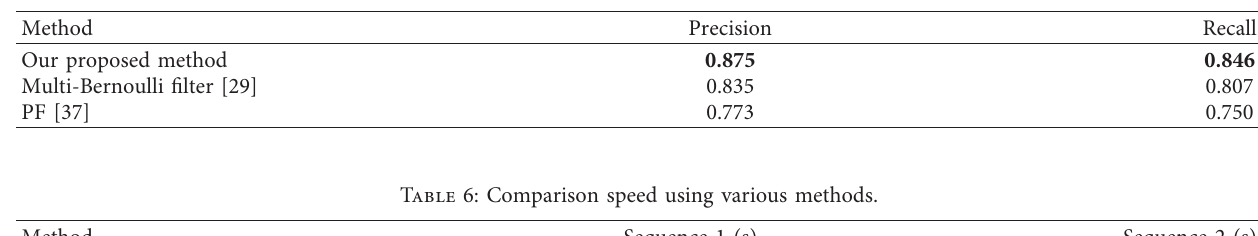
Table 5: Comparison results for tracking performance of various methods (sequence 2).